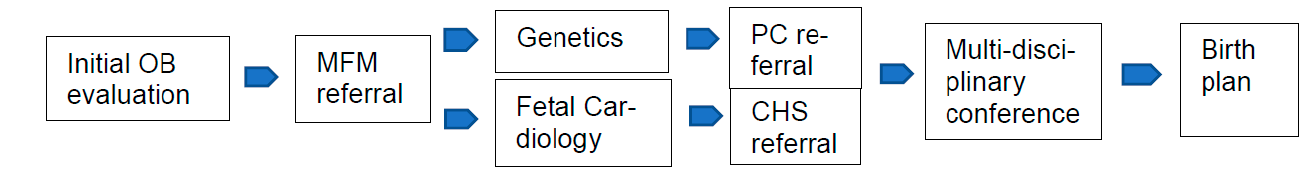
Figure 1. Proposed model for integration of a PC team into the care of high-risk fetal CHD diagnoses [28]. OB = obstetrics, MFM = maternal–fetal medicine, PC = palliative care, CHS = congenital heart surgery.